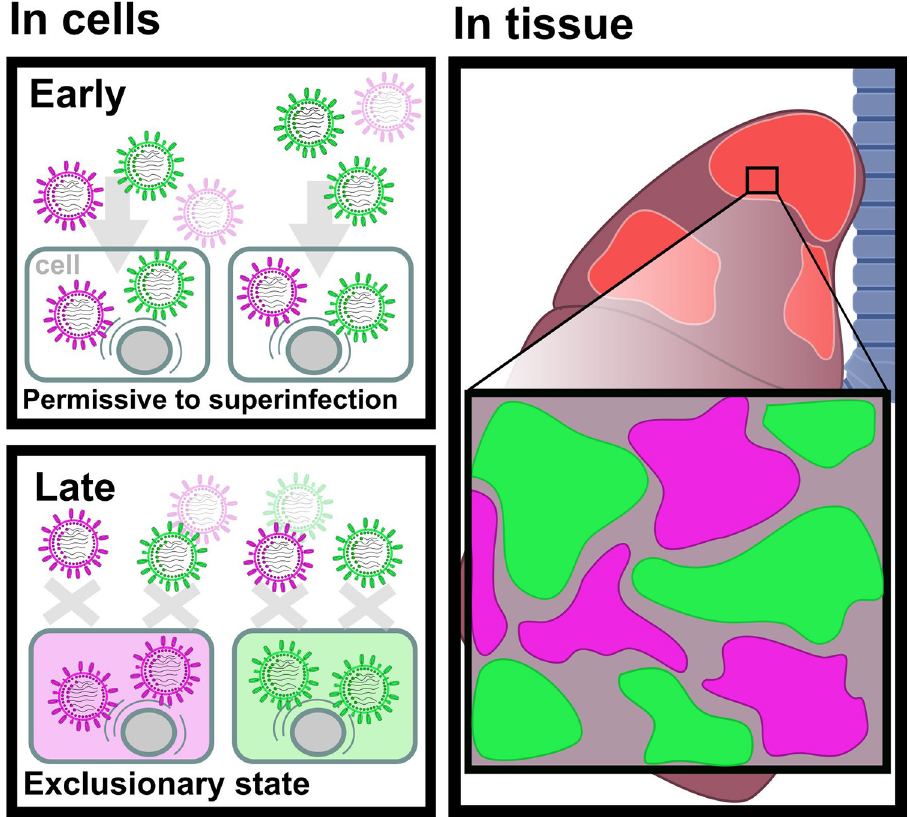
Fig 1. Superinfection exclusion within cells leads to spatial patterning within tissues. At early stages of the viral cycle, cells are permissive to infection of more than one virus, whereas in later stages, superinfection exclusion is set, impeding the reception of other viruses by the cell. Recent work in PLOS Biology shows that superinfection exclusion leads to a mosaic of discrete virus populations at the tissue